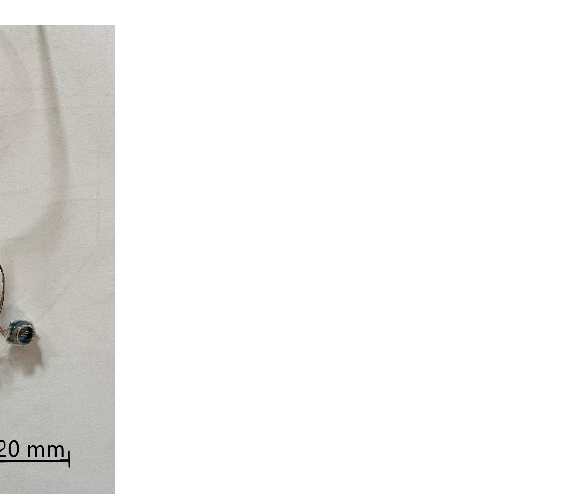
Figure 2. MS5407 pressure sensors soldered to the cables, shrinking tube uniquely identifies each sensor.